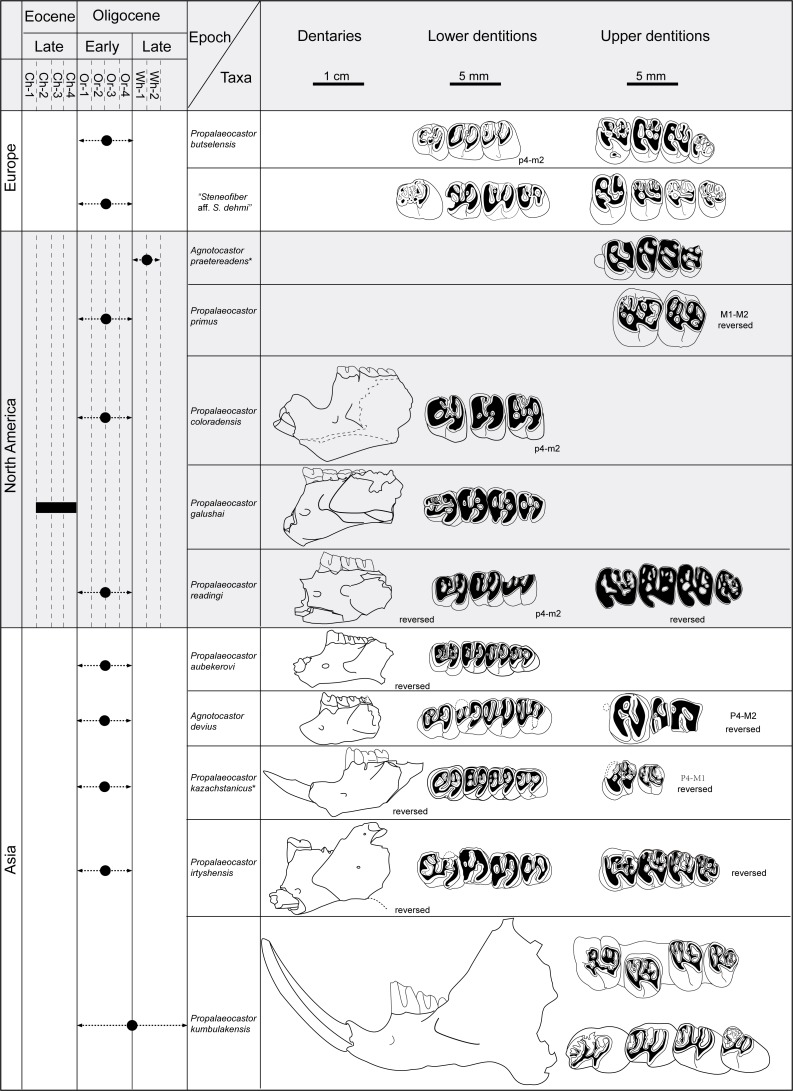
Chronologic and geographic distribution of Propalaeocastor and Agnotocastor, and comparisons of dentary and dental patterns.Displaying the developments of digastric eminence and angular process of the mandible extending orientations of their mandibles and similarities of dental constructions. Asterisk showing the type species of Agnotocastor and Propalaeocastor. Except for the figures of Propalaeocastor irtyshensis (dentary, IVPP V 23141; lower dentition, IVPP V 23139, upper dentition, IVPP V 13690), the illustrations in the Dentaries, Lower Dentitions and Upper Dentitions columns are facsimiles of their original figures (Stirton, 1935; Wilson, 1949b; Borisoglebskaya, 1967; Lytschev, 1970; Emry, 1972; Hugueney, 1975; Lytschev, 1978; Korth, 1998; Korth, 1996a; Korth, 1998; Lytschev & Shevyreva, 1994). Abbreviations used in left column are biochrons of North American Land-Mammal Ages (NALMA): Ch-1 = Early Chadronian; Ch2-3 = Middle Chadronian; Ch4 = Late Chadronian; Or1–Or4 = Orellan; Wh1–Wh2 = Whitneyan (see Flynn & Jacobs, 2008). Dentaries and dentitions are in same scales, respectively.